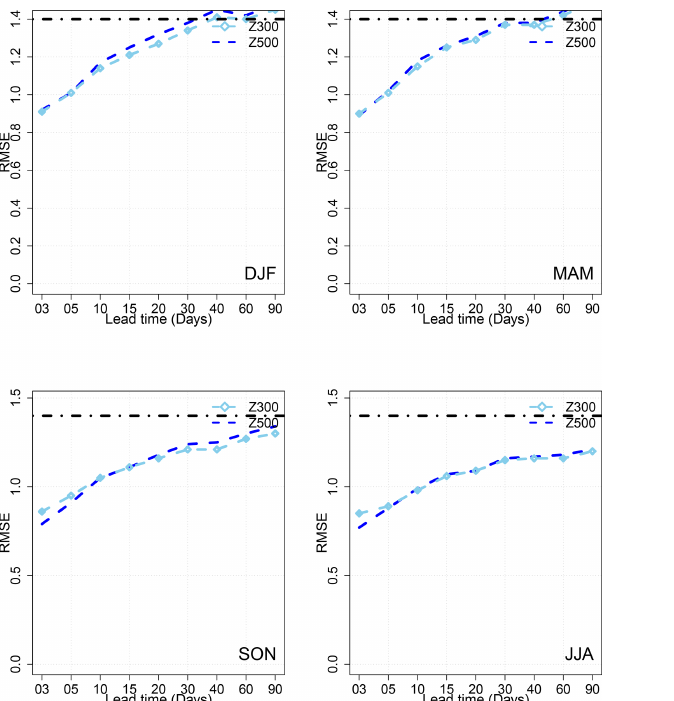
Figure A2. RMSE values for different lead times of forecasts from 3 to 90d over the period from 1979 to 2020 for the SWG forecast based on analogs of Z500 and Z300 for different seasons (DJF, JJA, MAM, and SON).